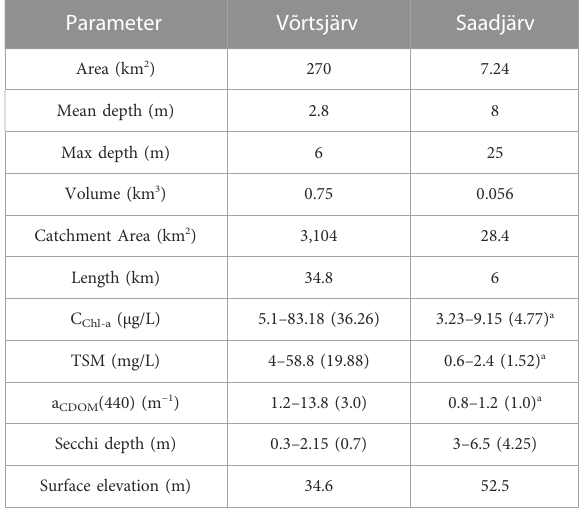
TABLE 1 Main morphological and bio-optical parameters in Võrtsjärv and Saadjärv. Mean values are given in parentheses. TSM refers to total suspended matter (mg/L) and a CDOM (442) to the absorption of coloured dissolved organic matter at 440 nm.